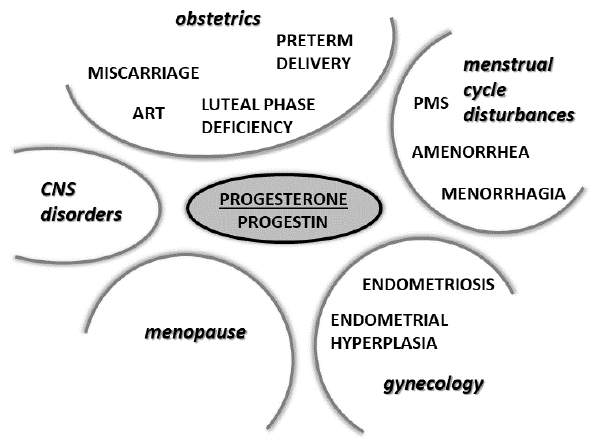
Figure 6. Spheres of influence of progesterone/progestin treatment in women’s health. ART — assisted reproductive technology, PMS — premenstrual syndrome.